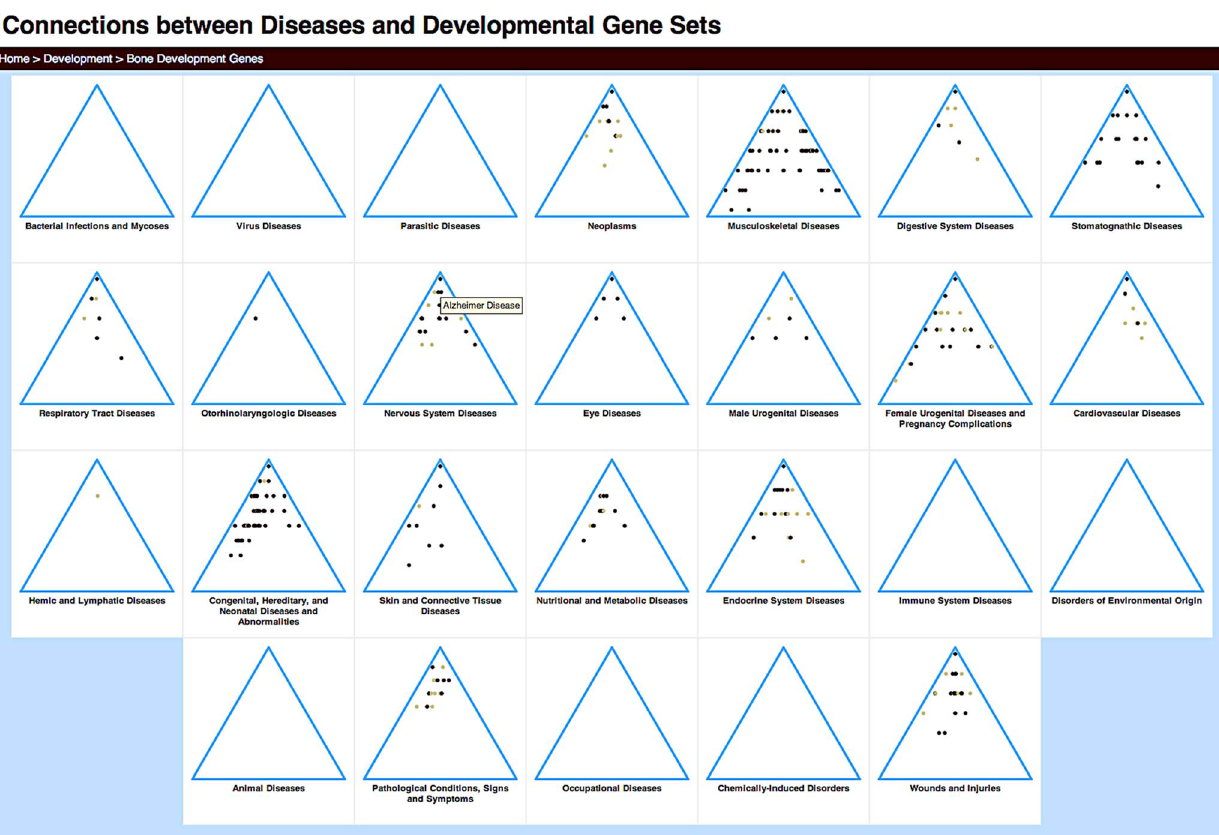
Figure 3. Triangle view of disease enrichment for the bone development gene set. Each triangle represents one of the 26 top-level categories in the MeSH disease forest. Each dot represents a disease node with significant enrichment of brain development genes. To clearly indicate the significance of relationships between diseases and the query gene set in these small images, we used two colors: light brown dots indicate p v 0 : 005 , and darker brown dots, p v 0 : 001 . Mousing over the dots reveals a pop-up of the disease term associated with that node (Alzheimer Disease is shown). Clicking on the category name leads to a detailed view of that tree.